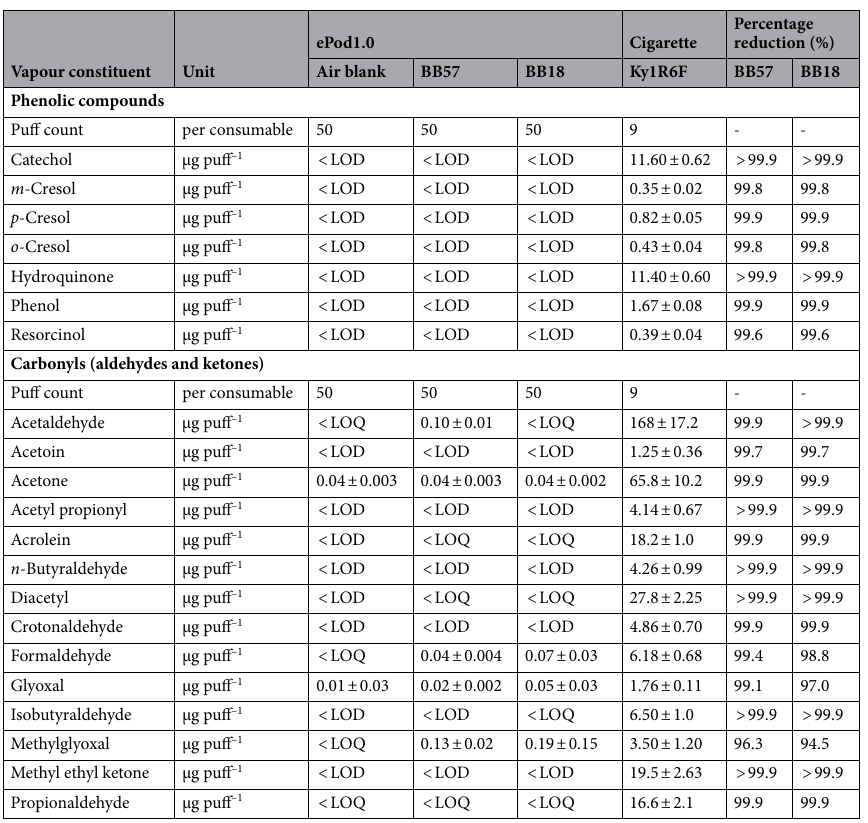
Table 3. Phenolic compounds, carbonyls and ketones: per-puff concentration of e-cigarette vapour emissions, respective method air blanks and Ky1R6F cigarette smoke. Values are presented as mean ± standard deviation (n = 5). Percentage reduction of e-cigarette emissions relative to Ky1R6F cigarette smoke. LOD limit of detection, LOQ limit of quantification. More information about the analytical methods and respective LODs and LOQs are under the Supplementary Information (Tables S1 and